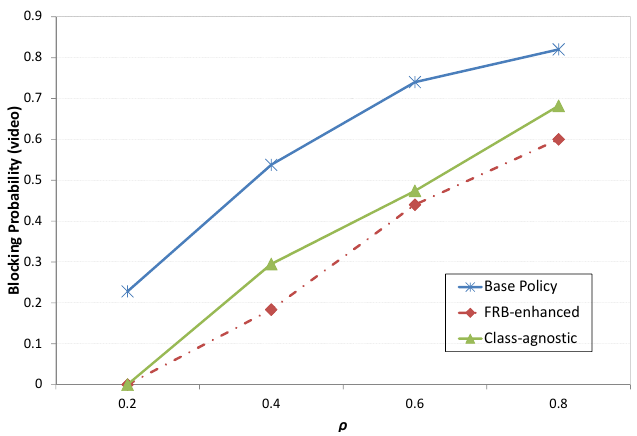
Figure 15. Class 2 (video) services blocking probabilities for the three scenarios.